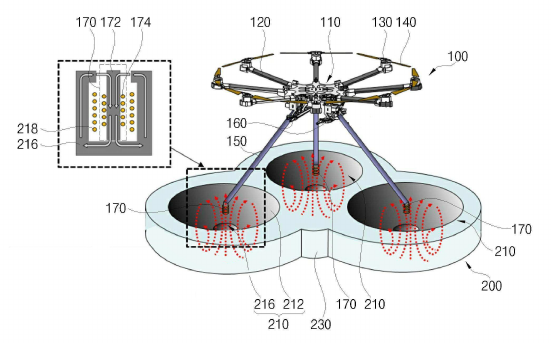
Figure 21. Three-phase AC-powered unmanned aerial vehicle and wireless charger [62]. 100, UAV; 150, UAV legs; 170, power receiving unit (coils); 210, landing pad; 212, conical funnels; 214, central hole (not shown); 218, feeding